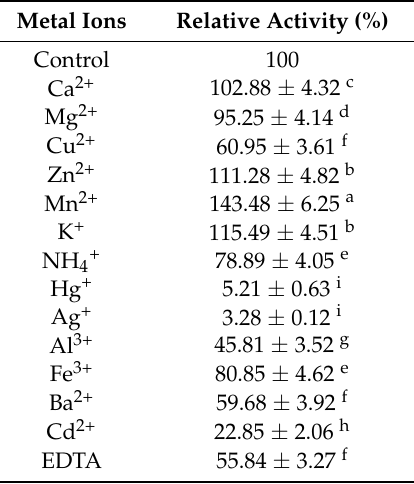
Table 4. Effect of metal ions on the activity of